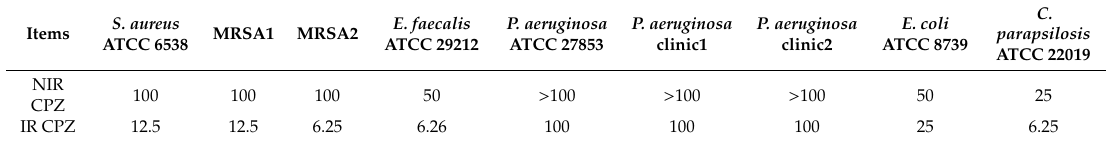
MICs are expressed in µ g / mL. NIR-CPZ = non-irradiated CPZ and IR-CPZ = irradiated CPZ.